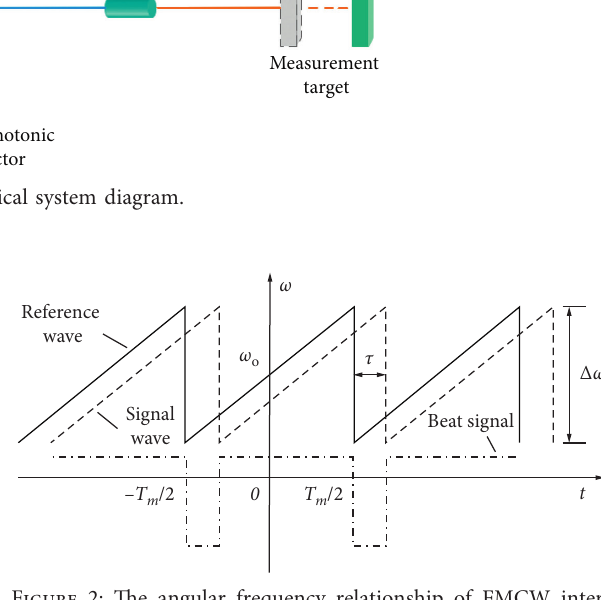
Figure 2: The angular frequency relationship of FMCW inter- ference signal under sawtooth wave